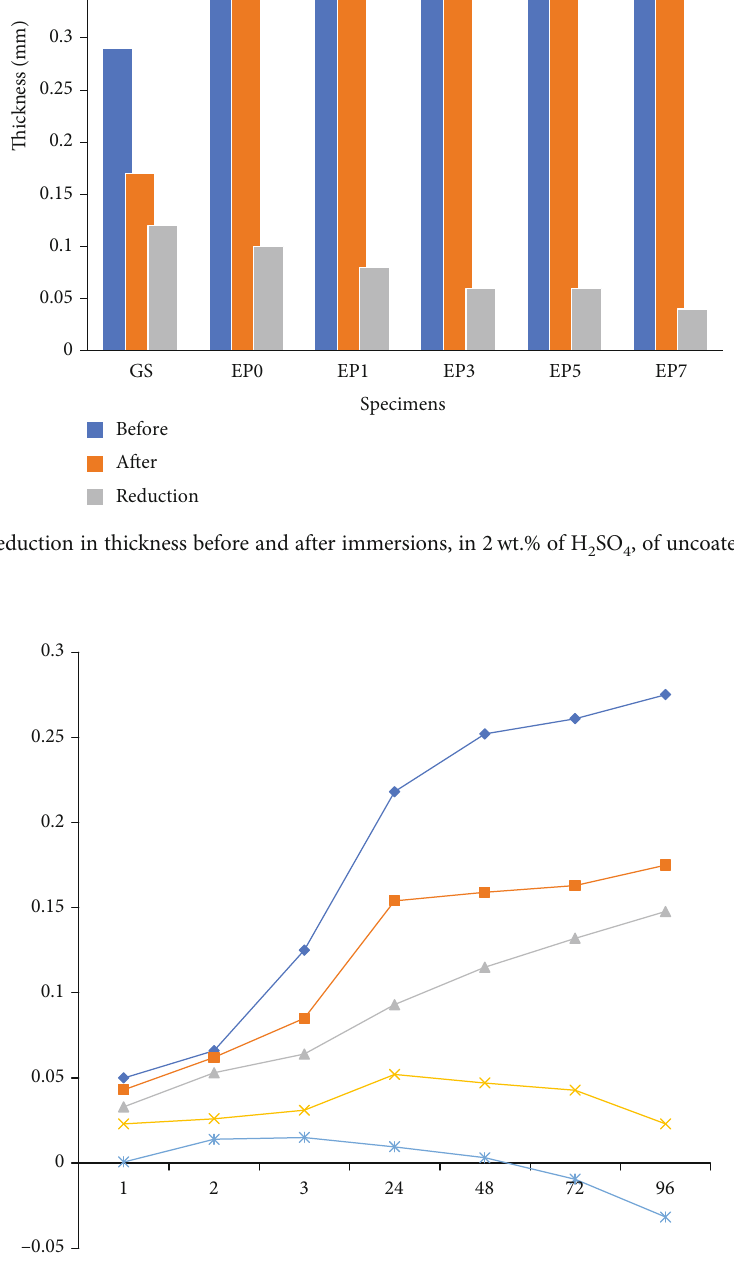
Figure 11: Percent weight gain of epoxy and epoxy composite after 96h immersion in distilled